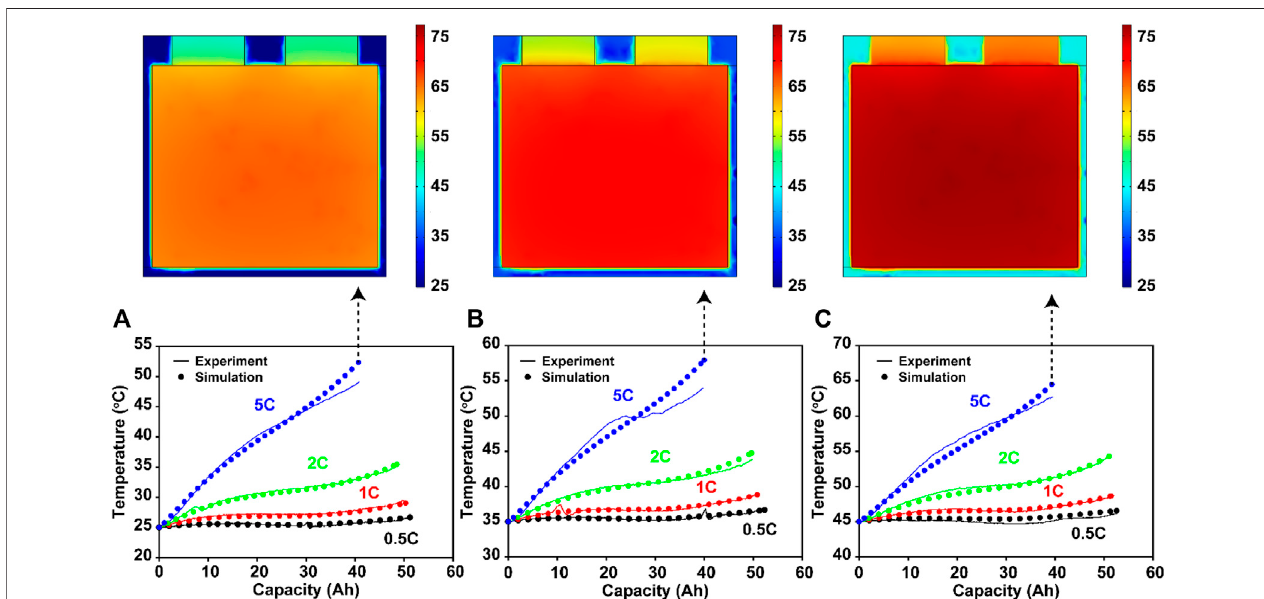
FIGURE 5 | Simulated temperature pro fi les of the cell model as a function of the C-rate (0.5, 1, 2, and 5C) at exterior temperatures of (A) 25 ° C, (B) 35 ° C, and (C) 45 ° C. Experimentally measured data are also depicted in each graph. At the top, the simulated temperature distribution images over the cell are displayed in the 3D domain.